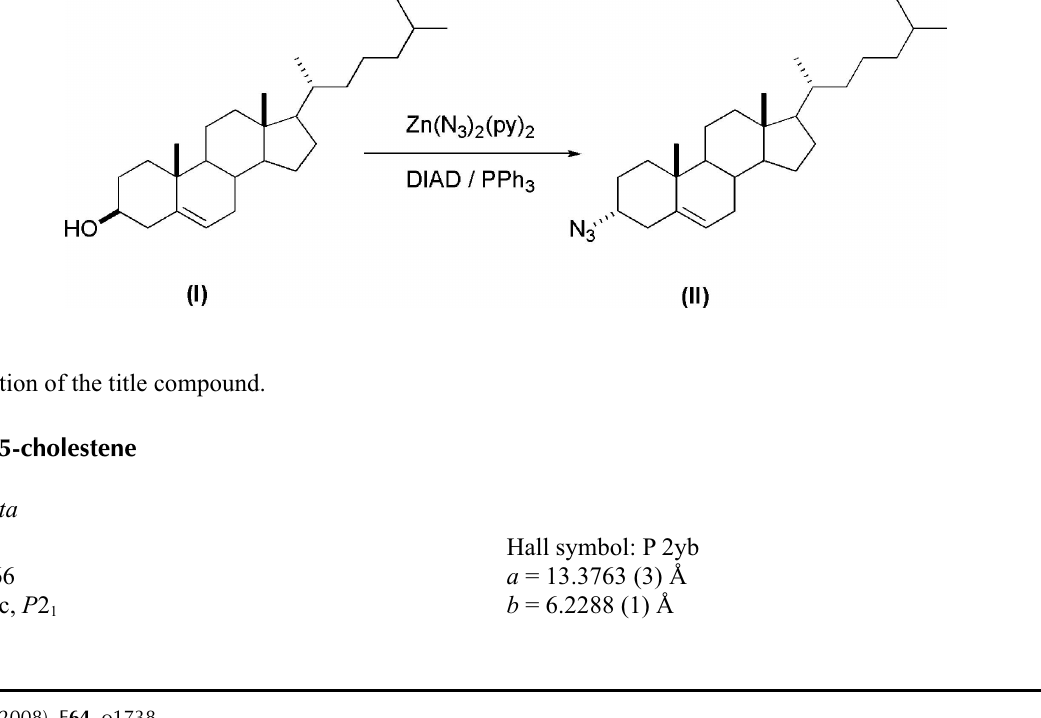
The molecular structure of (II), with atom labels and 40% probability displacement ellipsoids for non-H atoms.